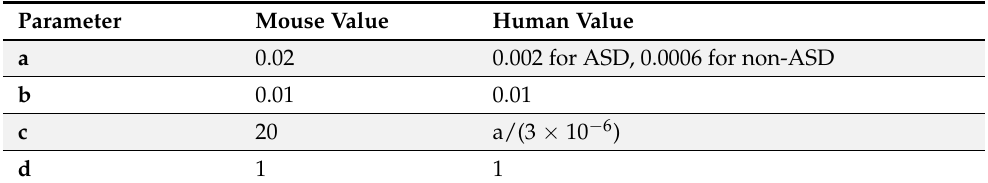
Table A1. Parameters needed to describe serotonin synthesis capacity data for ASD and non-ASD children in the data reported by [17].